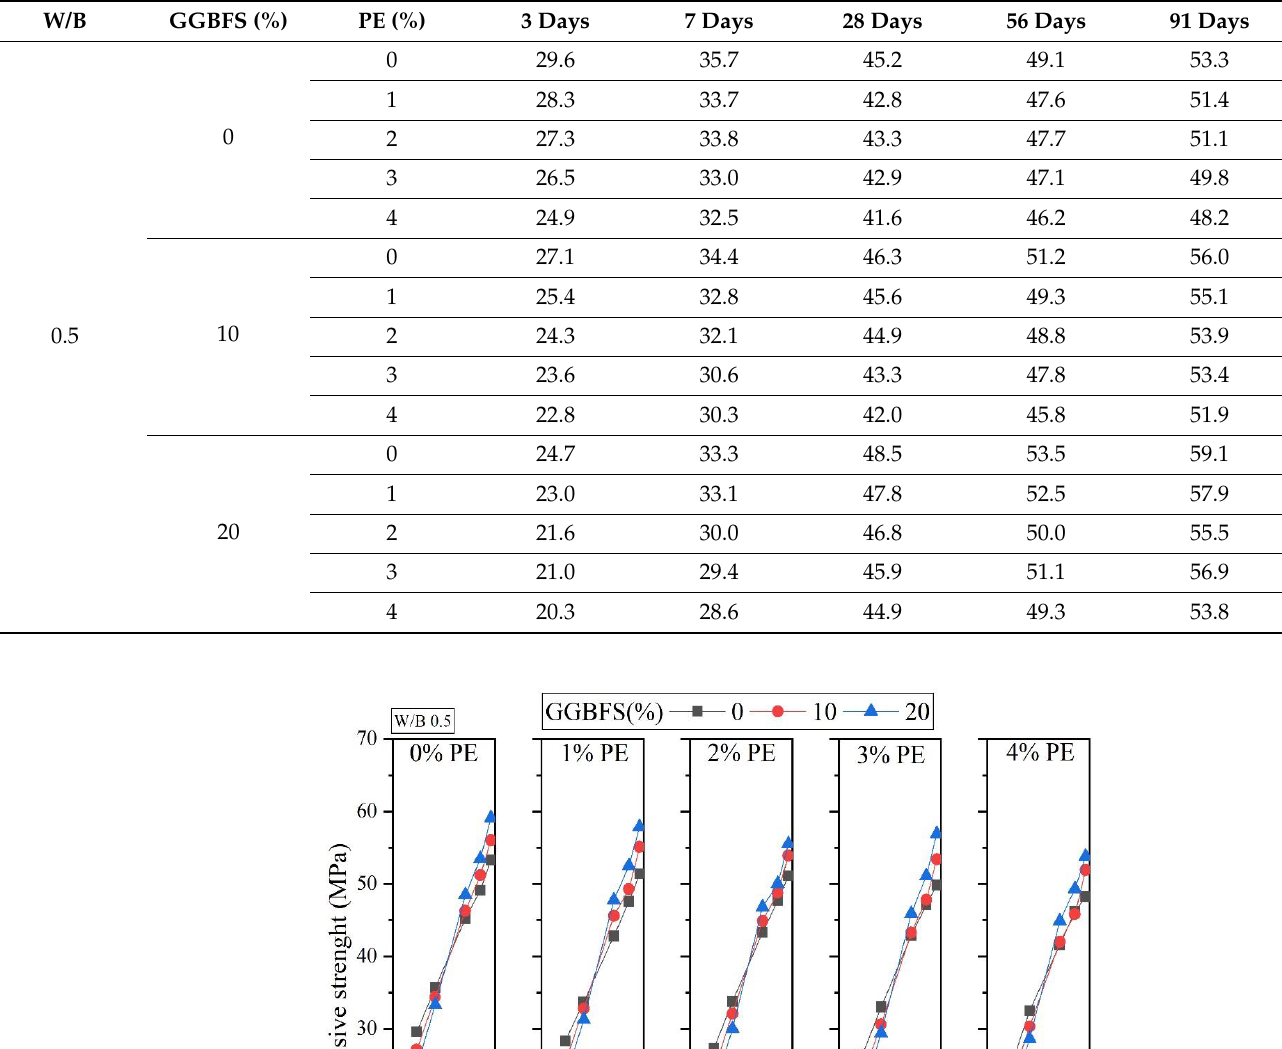
Table 5. Compressive strength of cement mortars with the addition of different ratios of waste PE and GGBFS replacement (unit: MPa).